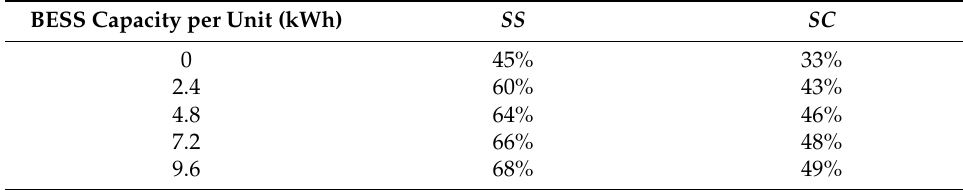
Table 10. Main results of the first scenario.